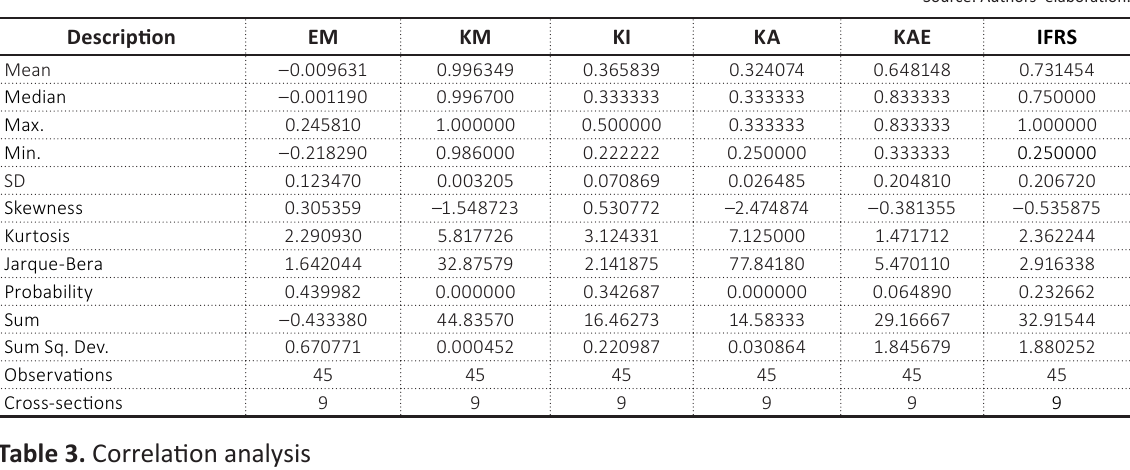
Table 2. Description of statistical data